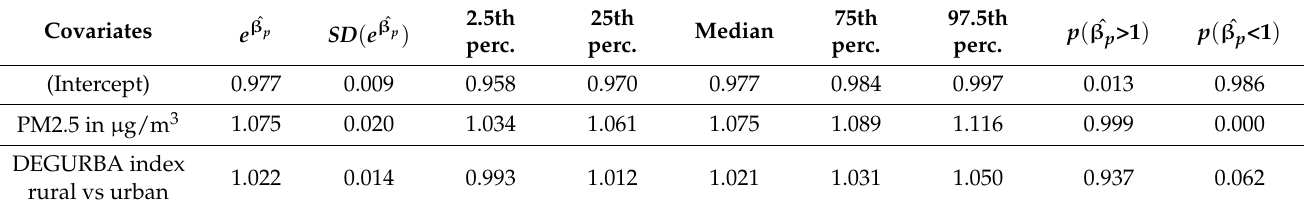
Table A1. Summary statistics of marginal posterior distribution of the exponential transformation of regression parameters of our best proposed model. Posterior probabilities (PPs) can be seen as “ p -values” complementary to 1. In the first column, there is the mean of the marginal posterior distributions (MPDs) of a parameter (OR), and in the second column, the standard deviation of that parameter. In the following 5 columns, there are the percentiles (perc.) of MPD. Finally, in the last two columns, there are the posterior probability (PP) that the estimated parameters are more, p ( ˆ β p > 1 ) , or less, p ( ˆ β p < 1 ) , than 1. A predictor was defined as a risk factor if it has a p ( ˆ β p > 1 ) close to 1; conversely, a parameter associated with a protective factor will have p ( ˆ β p < 1 ) close to 1.